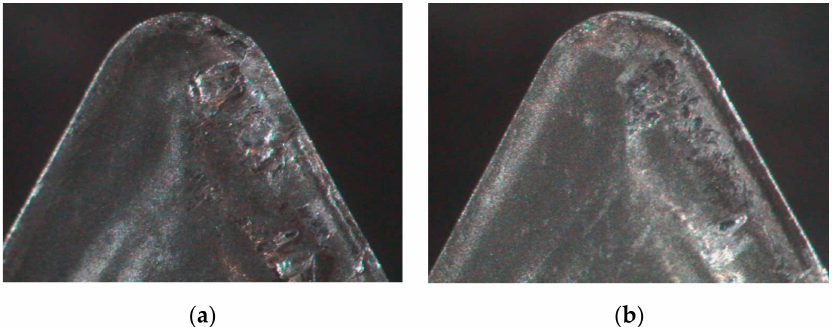
Figure 9. Stereoscopic optical microscopy (SOM) of the tool rake face (40 × ) after the tests performed for ( a ) f = 0.15 mm / r and ( b ) f = 0.20 mm / r, for v c = 80 m / min.